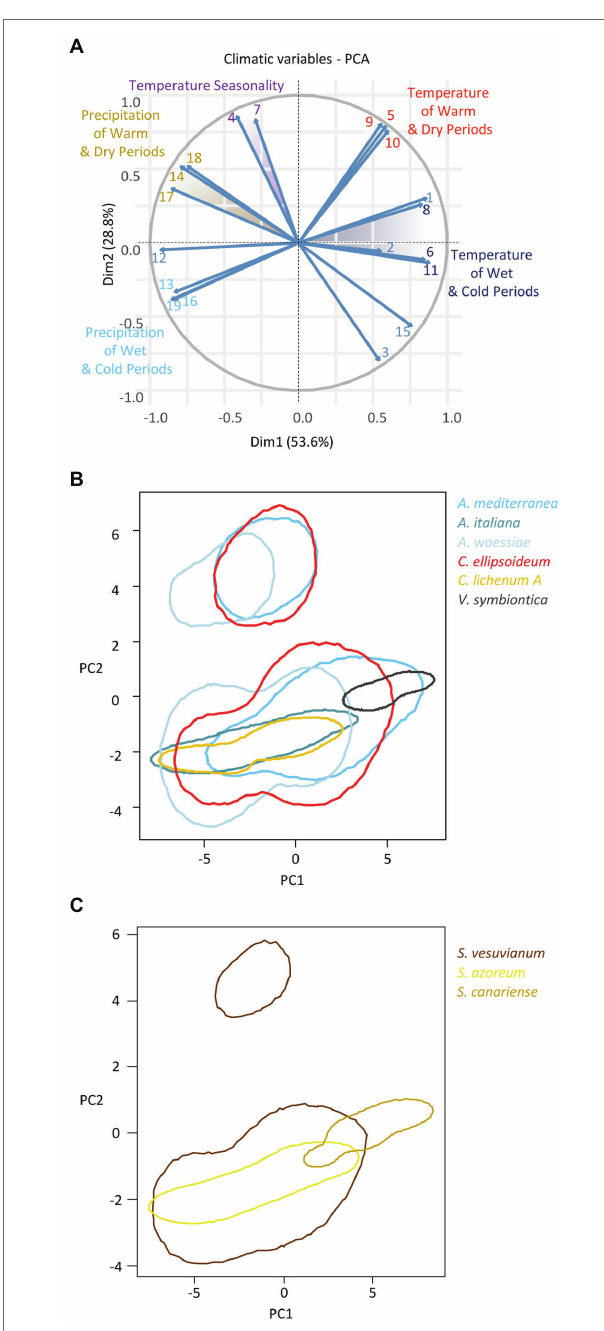
FIGURE 7 | (A) Principal coordinate analysis of 19 Bioclim variables: 1 = annual mean temperature, 2 = mean diurnal range, 3 = isothermality, 4 = temperature seasonality, 5 = max temperature of warmest month, 6 = min temperature of coldest month, 7 = temperature annual range, 8 = mean temperature of wettest quarter, 9 = mean temperature of driest quarter, 10 = mean temperature of warmest quarter, 11 = mean temperature of coldest quarter, 12 = annual precipitation, 13 = precipitation of wettest month, 14 = precipitation of driest month, 15 = precipitation seasonality, 16 = precipitation of wettest quarter, 17 = precipitation of driest quarter, 18 = precipitation of warmest quarter, 19 = precipitation of coldest quarter. Climatic niche hypervolumes for (B) six most abundant phycobiont species-level lineages and (C) three most abundant Stereocaulon mycobiont species-level lineages.